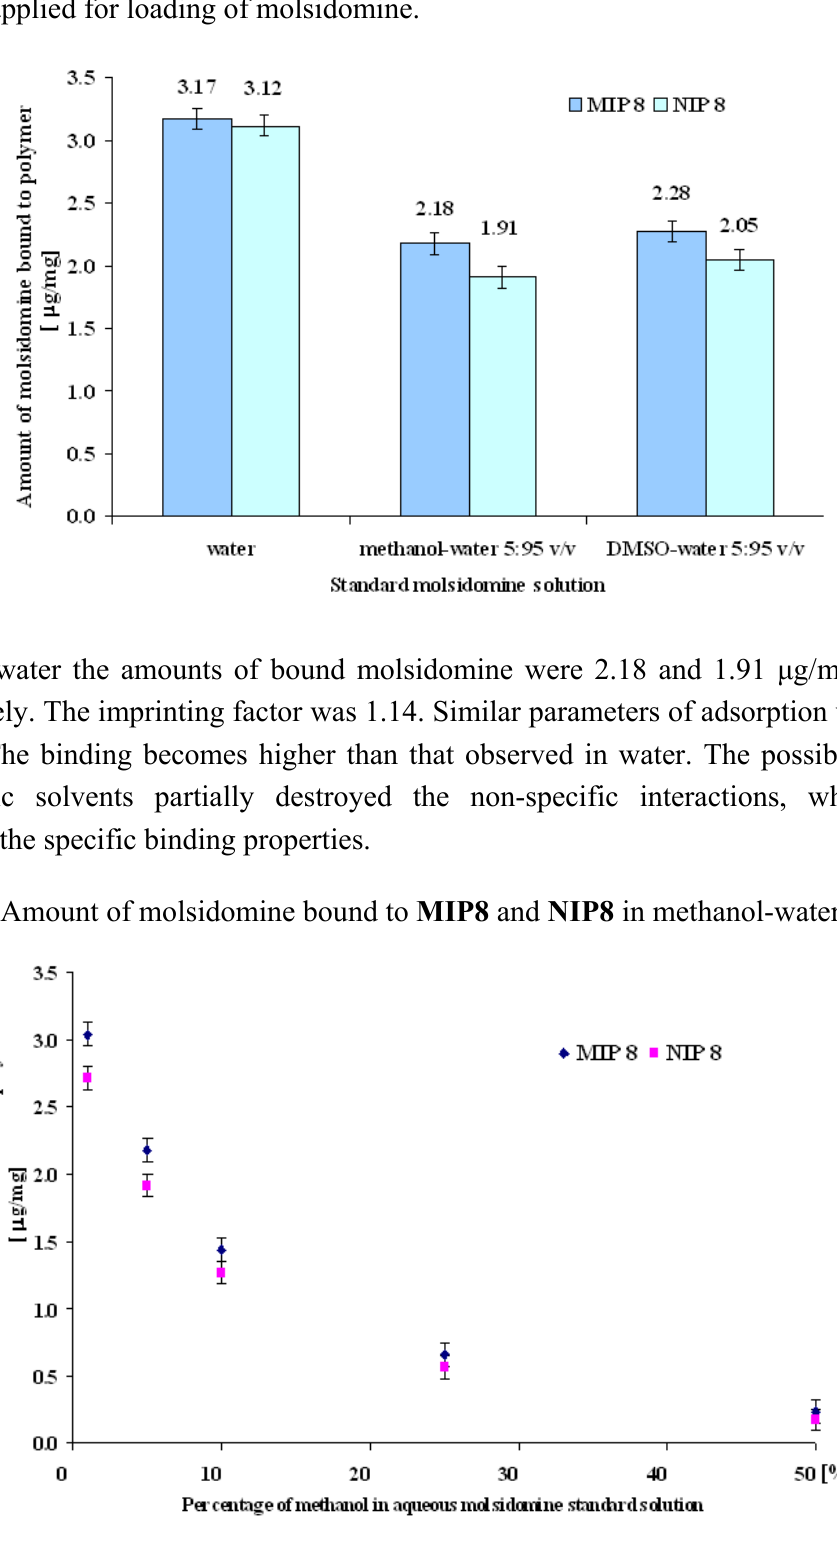
Figure 7 . Amount of molsidomine bound per mg of polymer with different standard solutions applied for loading of molsidomine.